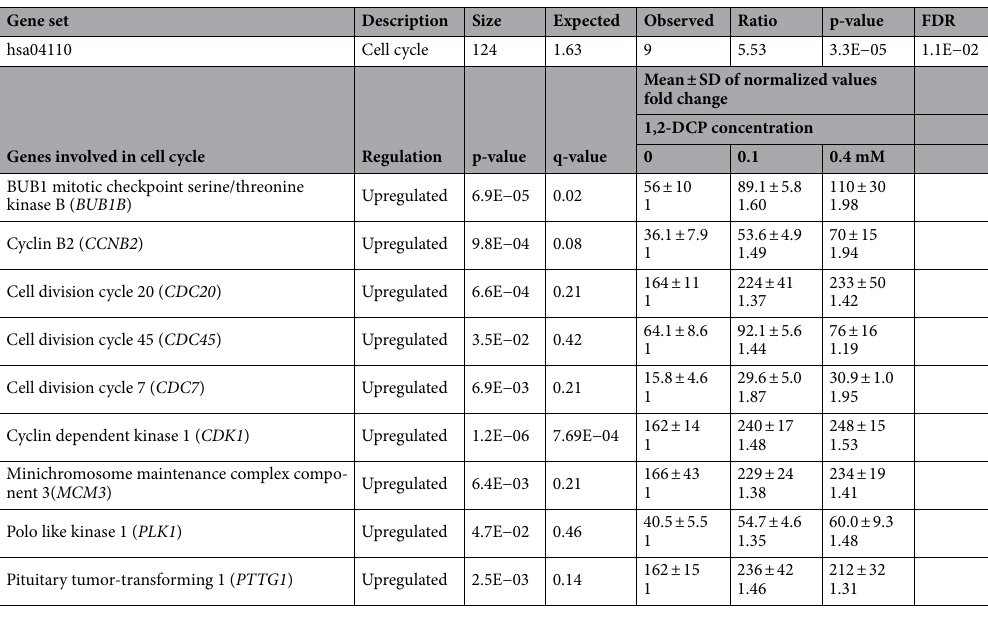
Table 3. KEGG pathway overrepresentation analysis of ME2 module and list of involved genes in THP-1 macrophages co-cultured with MMNK-1 cholangiocytes. The table shows KEGG pathway overrepresentation analysis of ME2 module and involved genes from the transcriptomic profiles of THP-1 macrophages co-cultured with MMNK-1 cholangiocytes when exposed to 1,2-DCP at 0, 0.1 or 0.4 mM for 24 h. The analysis was performed by WebGestalt with False Discovery Rate (FDR) cut-off value of 0.05. Data of normalized values for gene expression are mean ± SD, n = 3. All p-values for gene expression were adjusted using Benjamini–Hochberg method and expressed as q-values. Fold change represents the value relative to the average of the control group (0